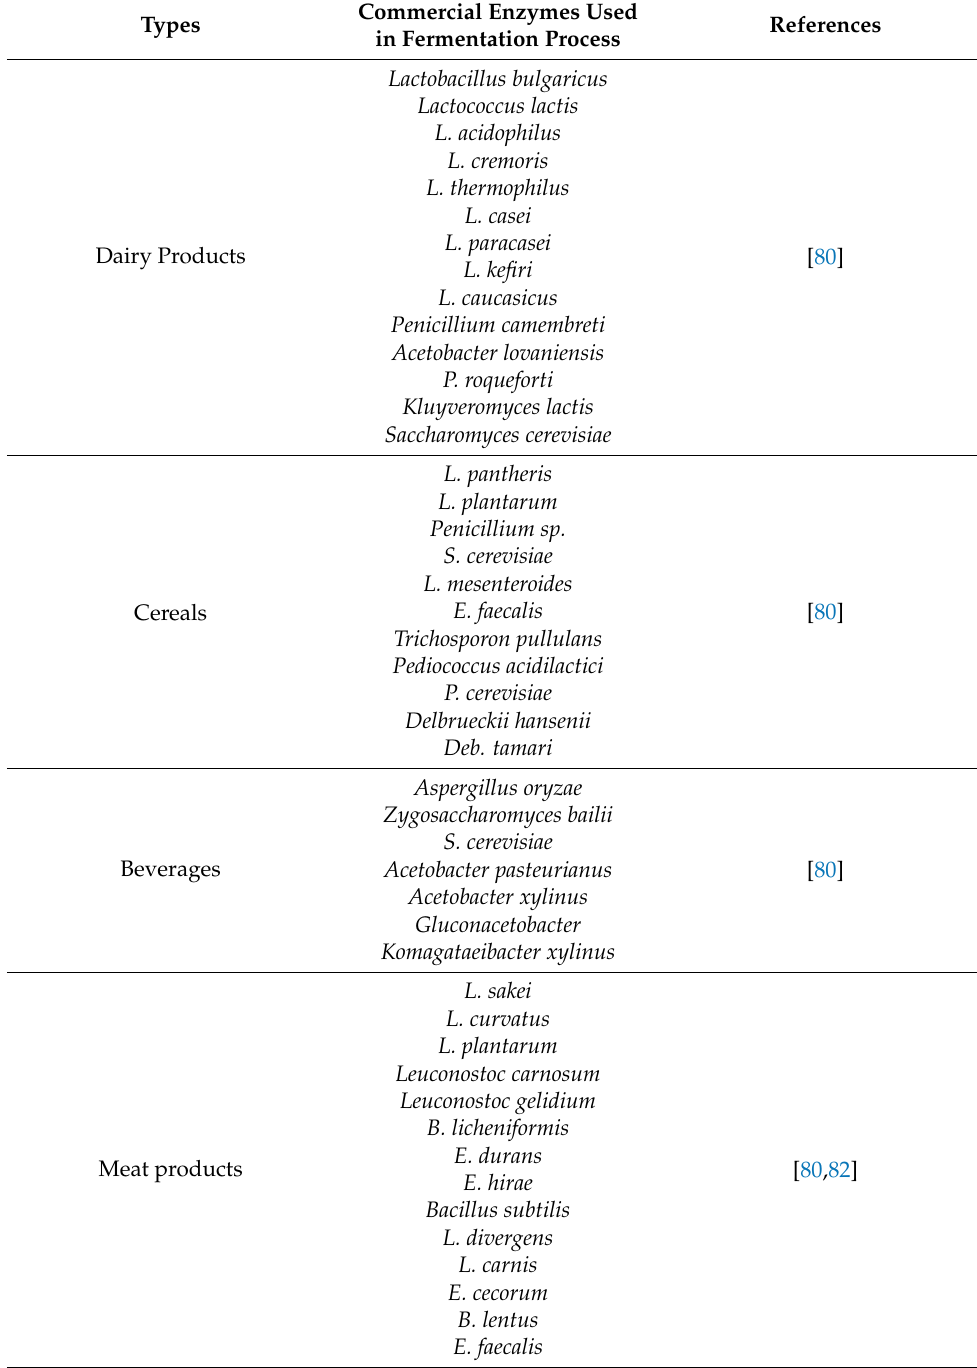
Table 1. Commercial enzymes applied in different fermentation